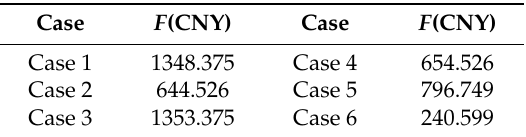
Figure 7. Charging load curve corresponding to ( a ) Case 1; ( b ) Case 2; ( c ) to Case 3; ( d ) Case 4; ( e ) Case 5; ( f ) Case 6. Table 3. Profit of charging station corresponding to each